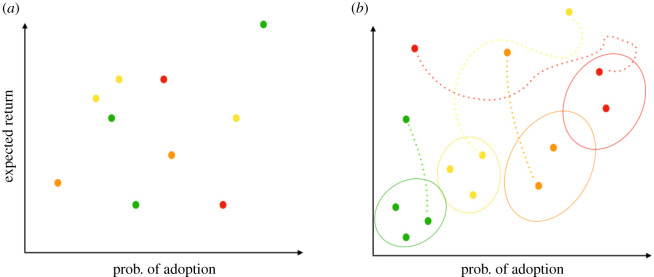
Schematic of the crypto assets dynamics. Circles of different colours represent crypto assets with different security–stability features. (a) At the beginning of the simulation of the dynamics, crypto assets of different types (depending on their security–stability parameters) are randomly placed in the probability of adoption–expected return space. (b) When investors start making their adoption choices, which will in turn impact the assets’ expected returns, crypto assets start moving and clustering in different regions of the probability of adoption–expected returns space depending on their features and the investors’ choices.